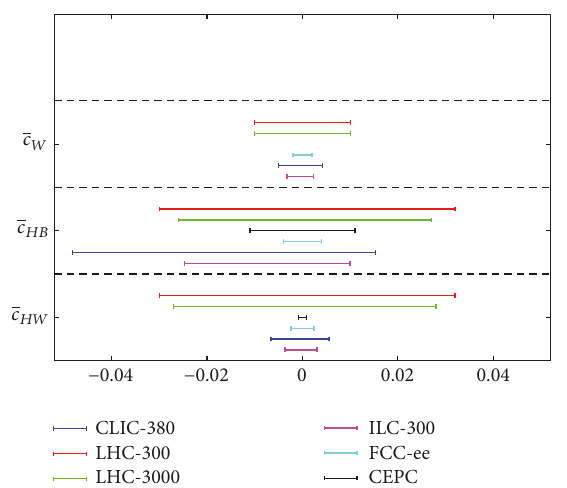
Figure 6: Obtained allowed range (CLIC-380); LHC at 14 TeV center-of-mass energies for the integrated luminosity of 300 fb −1 (LHC-300) and 3000 fb −1 (LHC-3000) [18]; ILC-300 at √𝑠 = 500 GeV with 𝐿 int = 300 fb −1 [23, 28]; FCC-ee for 𝐿 int = 10 ab −1 at −1 at √𝑠 = 240 GeV [32] at √𝑠 = 240 GeV [23]; CEPC for 𝐿 int = 5ab 95% CL for 𝑐 퐻푊 , 𝑐 퐻퐵 , and 𝑐 푊 = −𝑐 퐵 coefficients. The limits are each derived with all other coefficients set to